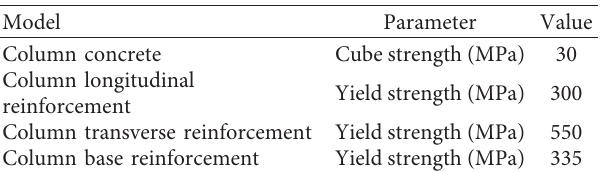
Table 2: Material mechanical properties of the column in ex- periment impact test.